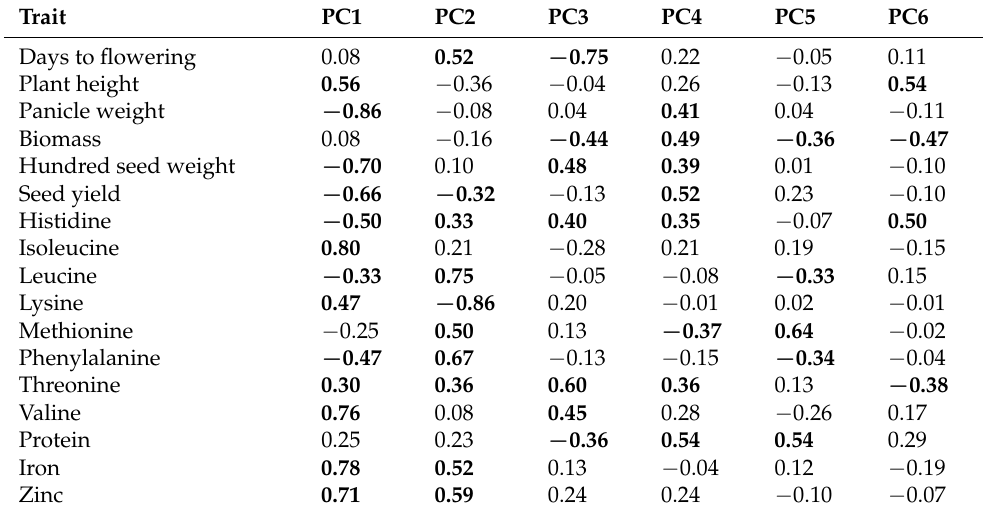
Table 4. Principal components (PC) for agronomic traits and nutritional compositions among 12 elite sorghum genotypes.